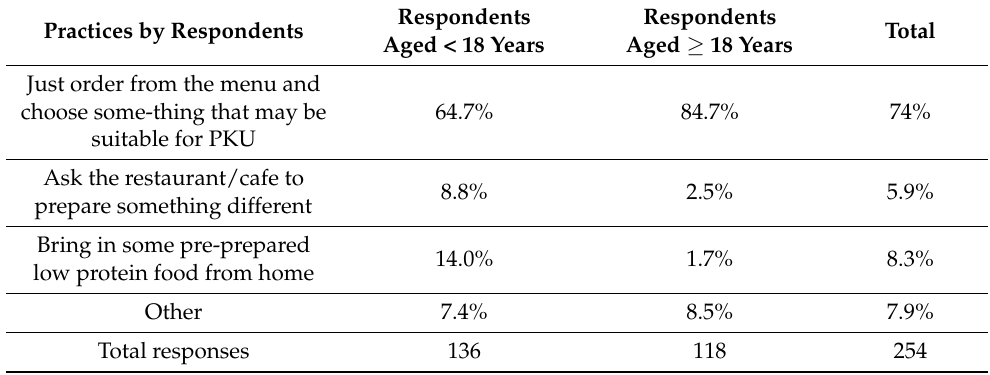
Table 3. What people with PKU normally do when eating out divided by age of respondents ( n = 254).